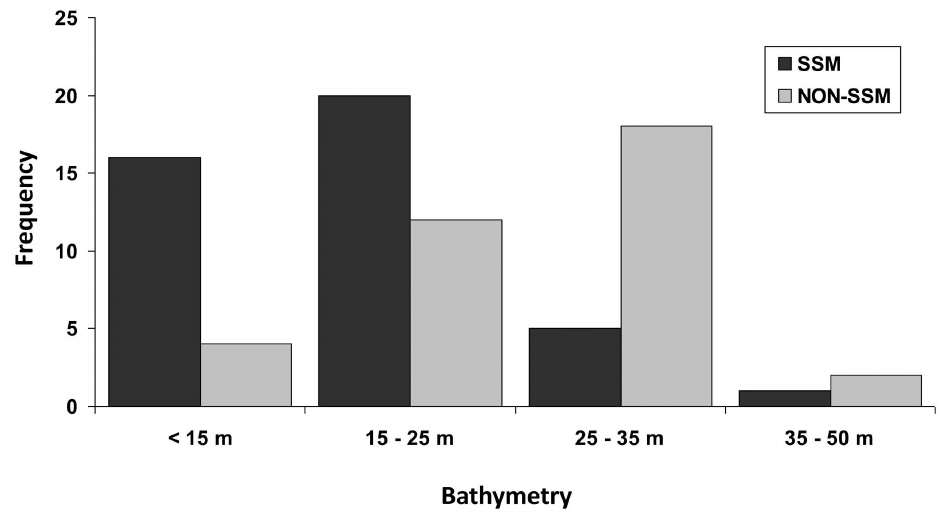
Fig 6. Bathymetry histogram for inter-nesting habitat Minimum Convex Polygon (MCPs) depth centroid locations for Kemp’s ridley turtles. Includesn = 58 tracked after nesting at Padre Island National Seashore, Texas, USA during1998 through 2013, n = 9at RanchoNuevo, Tamaulipas, Mexico during2010 and 2011, and n = 11 at Tecolutla, Veracruz, Mexico during2012 and 2013. SSM = depth centroidsfor turtles for which state space modelingwas successful (n = 56); NON-SSM = depth centroids for turtles for which SSM was not possible(n = 36).